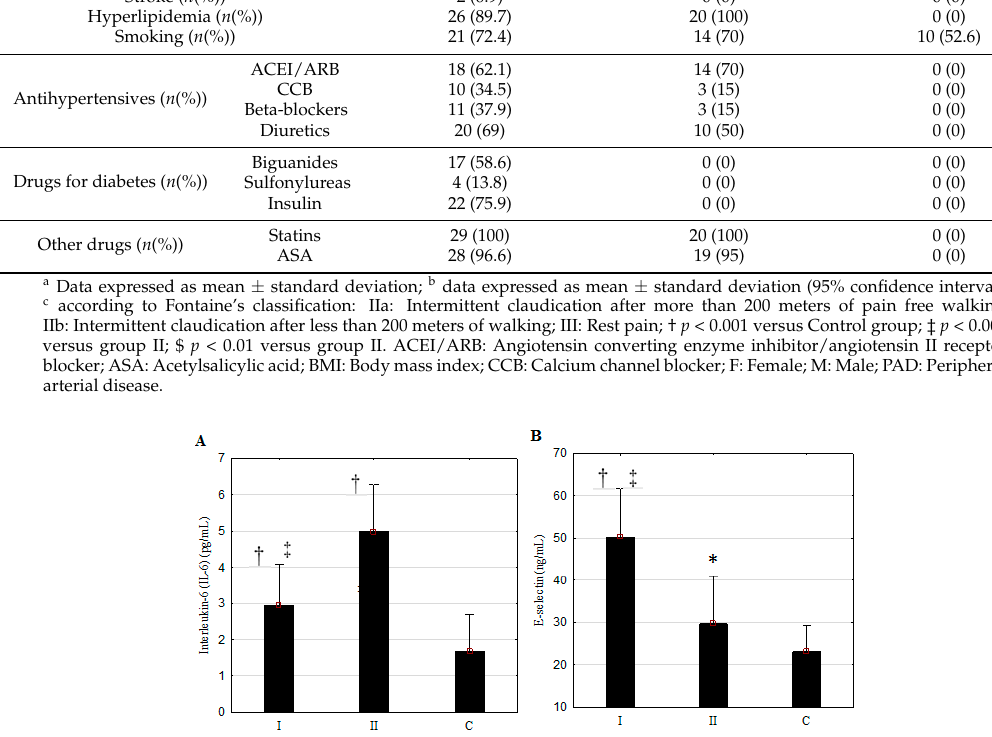
Figure 1. The concentrations of interleukin-6 (IL-6) ( A ) and E-selectin ( B ) in the blood serum in patients with peripheral arterial occlusive disease (PAOD) of the lower extremities; I: PAOD with n = 29; II: PAOD without diabetes, n = 20; C: Control group, n = 19; † p < 0.001 versus Control group; * p < 0.05 versus Control group; ‡ p < 0.001 versus group